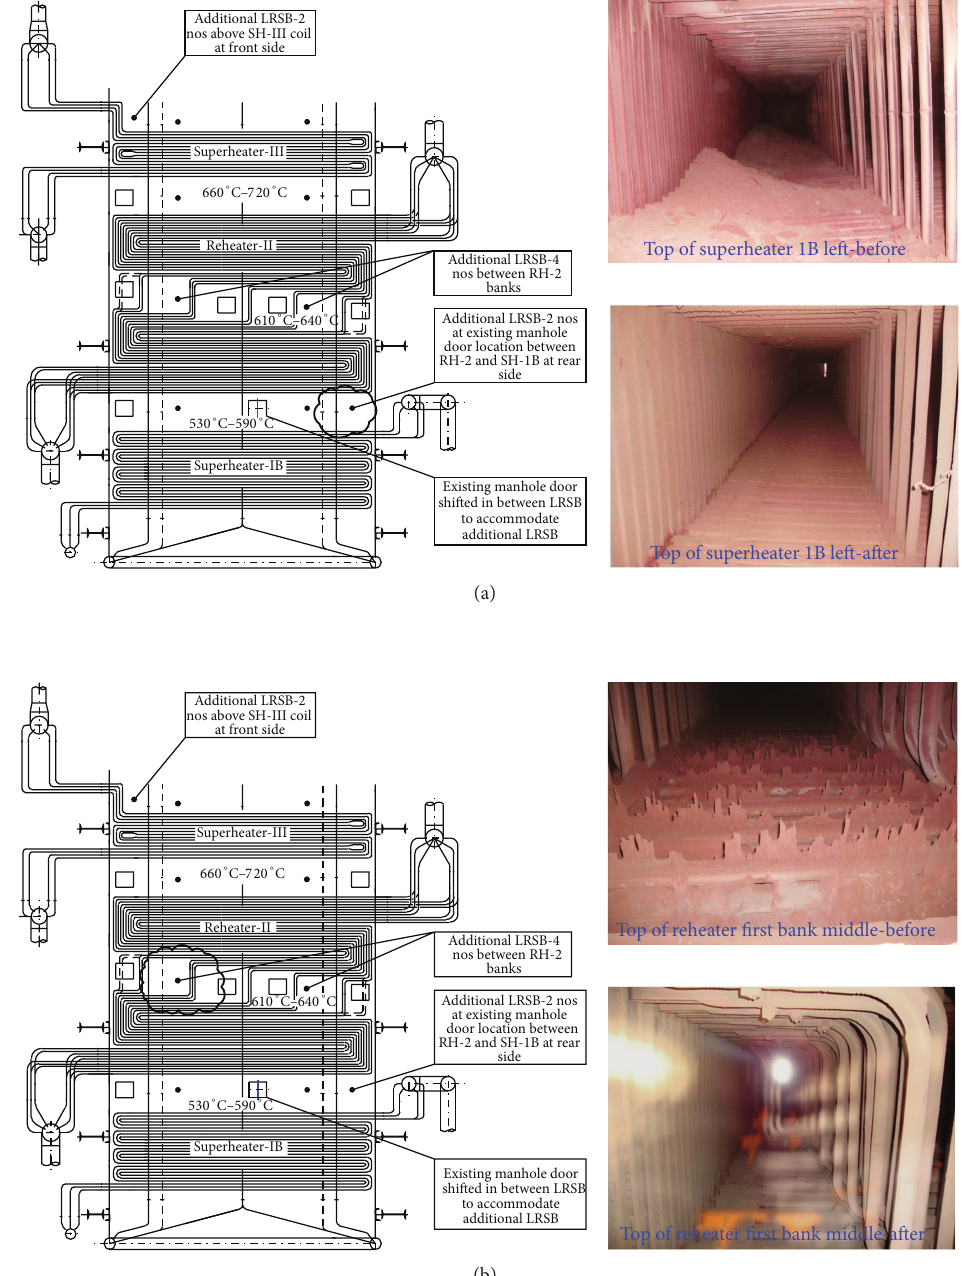
Figure 1: Deposits in superheater/reheater coils before and after introduction of high pressure soot blowers and location of additional soot blowers in